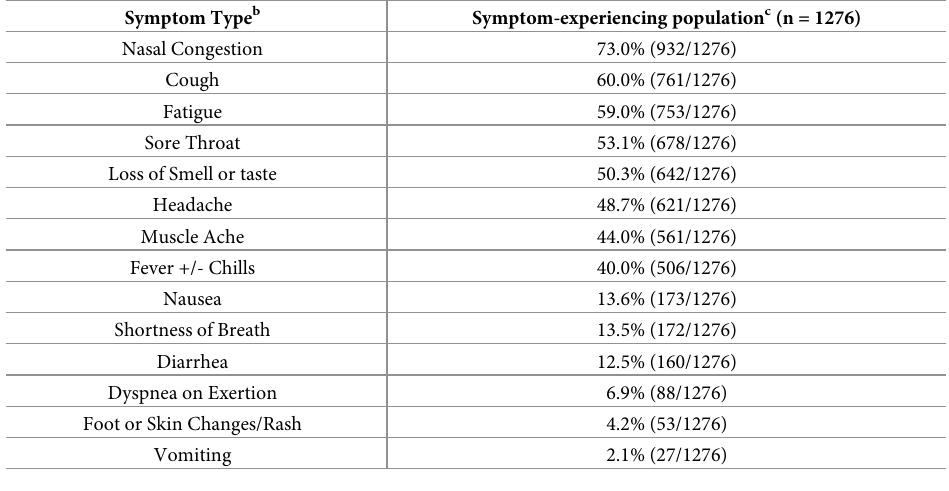
Table 5. Proportion of population experiencing symptoms a by symptom type.